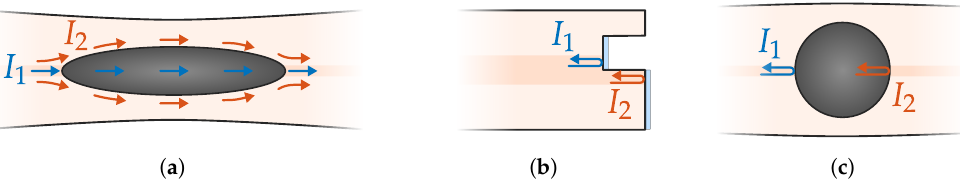
Figure 11. Typical interferometric sensors using in-fiber microcavities. The configurations used are ( a ) MZI, ( b ) Michelson interferometer (MI), ( c ) and Fabry–Perot interferometer